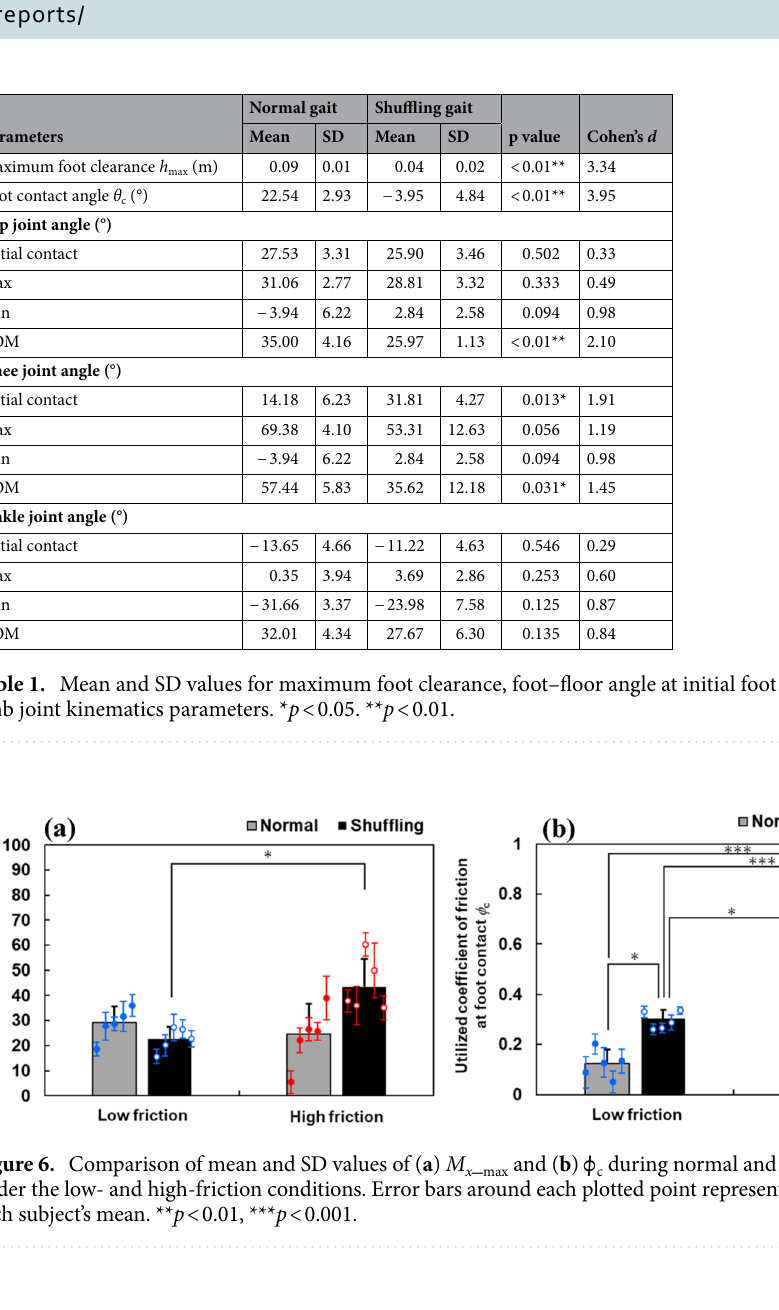
c during normal and shuffling gait trials ϕ